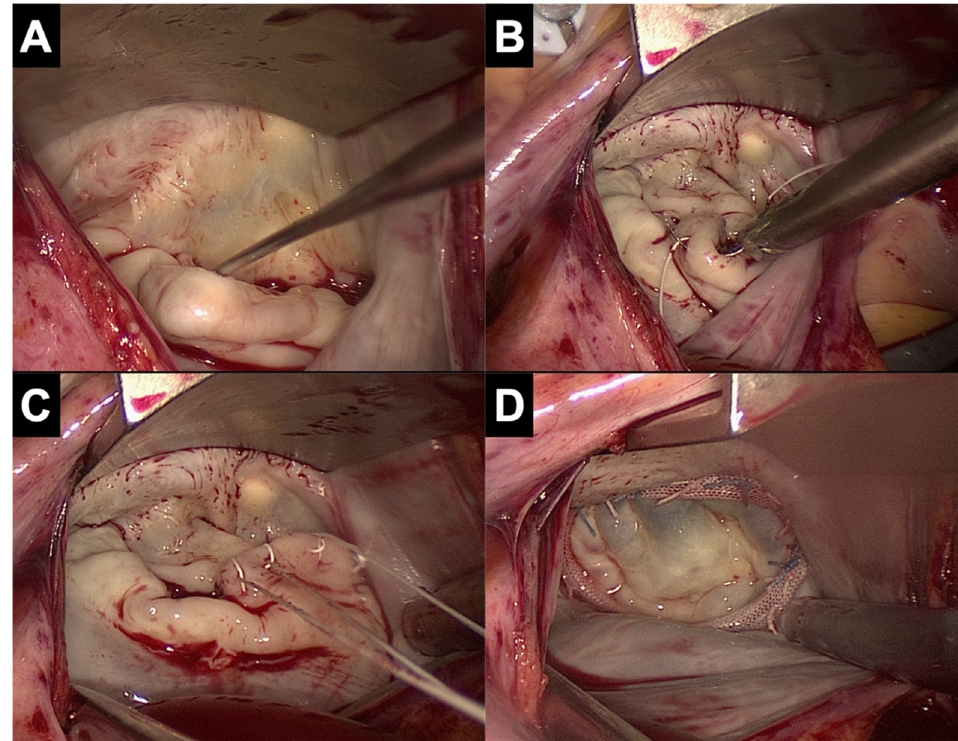
Figure 2. View on the mitral valve in MIMVS. ( A ) Prolapse of P2 segment. ( B ) Placement of neochords on the prolapsing segment. ( C ) Adjusting of the height of the neochords. ( D ) Result of mitral valve repair.